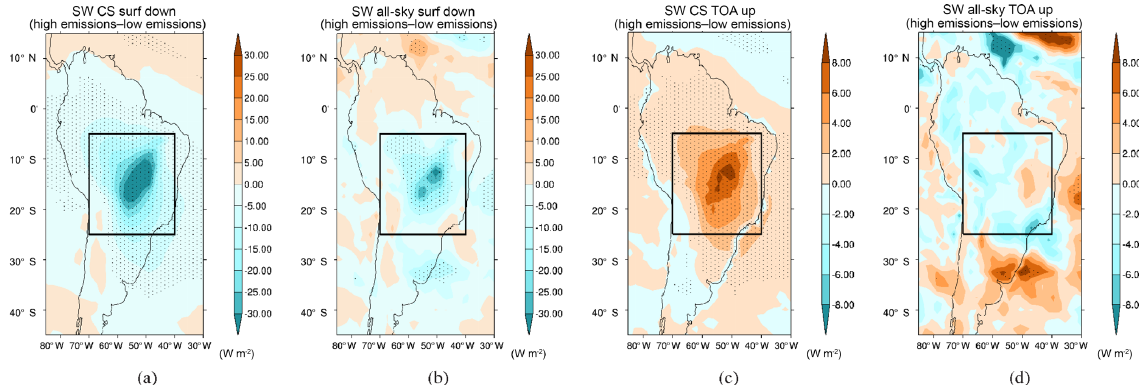
Figure 10. The September mean difference between high and low emissions cases for (a) the clear-sky downwelling SW radiation at the surface, (b) the all-sky downwelling SW radiation at the surface, (c) the clear-sky upwelling SW radiation at TOA and (d) the all-sky upwelling SW radiation at TOA. Stippling represents 95% confidence limit.